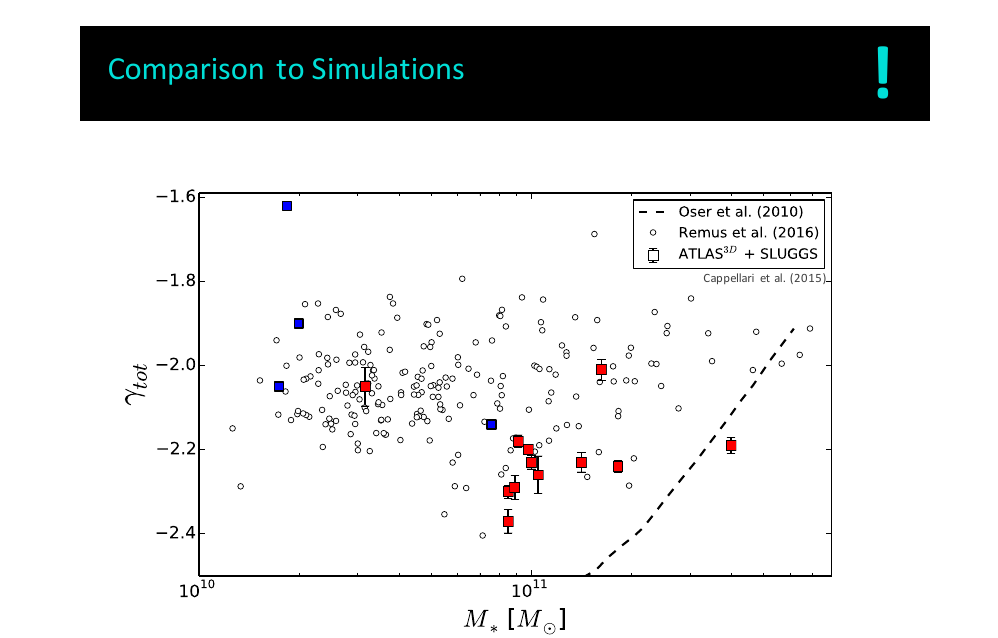
Figure 5. Preliminary plot of γ tot against stellar mass M ∗ for SLUGGS galaxies. Blue squares represent new measurements. Red squares indicate previously published JAM results from SLUGGS [7], and simulated results [8] are plotted in addition to an older prediction